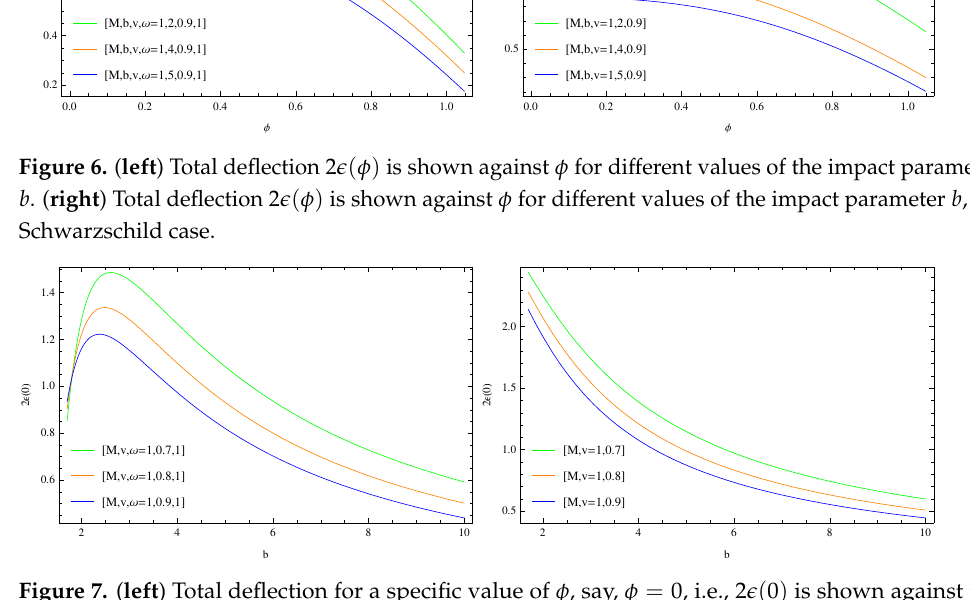
Figure 7. ( left ) Total deflection for a specific value of φ , say, φ = 0, i.e., 2 (cid:101) ( 0 ) is shown against the impact parameter b for different values of v . ( right ) Total deflection 2 (cid:101) ( 0 ) at φ = 0 is shown against the impact parameter b for different values of v , for Schwarzschild case.